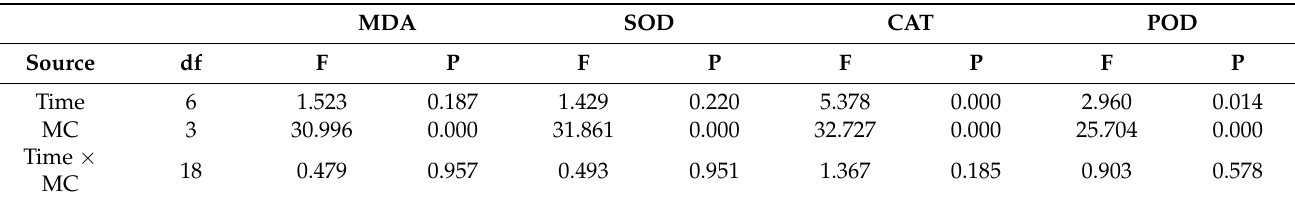
Table 2. Summary of 2-way analysis of variance testing the effects of time and modified clay on MDA, SOD, CAT, and POD in marine